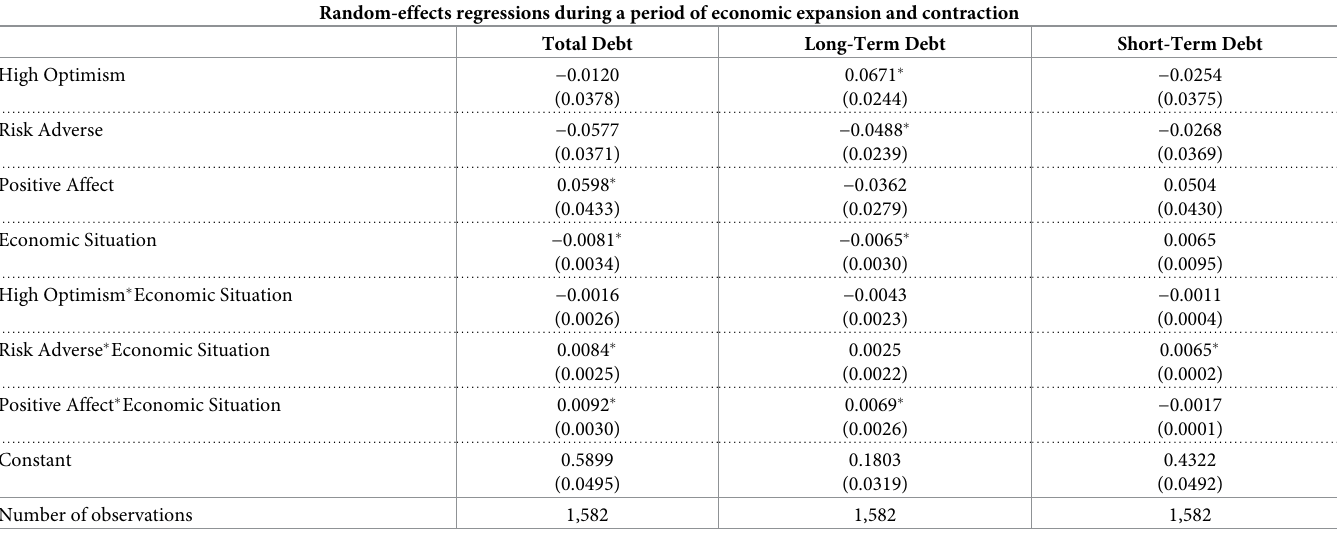
Table 4. Random-effects regression models in expansion and contraction economic